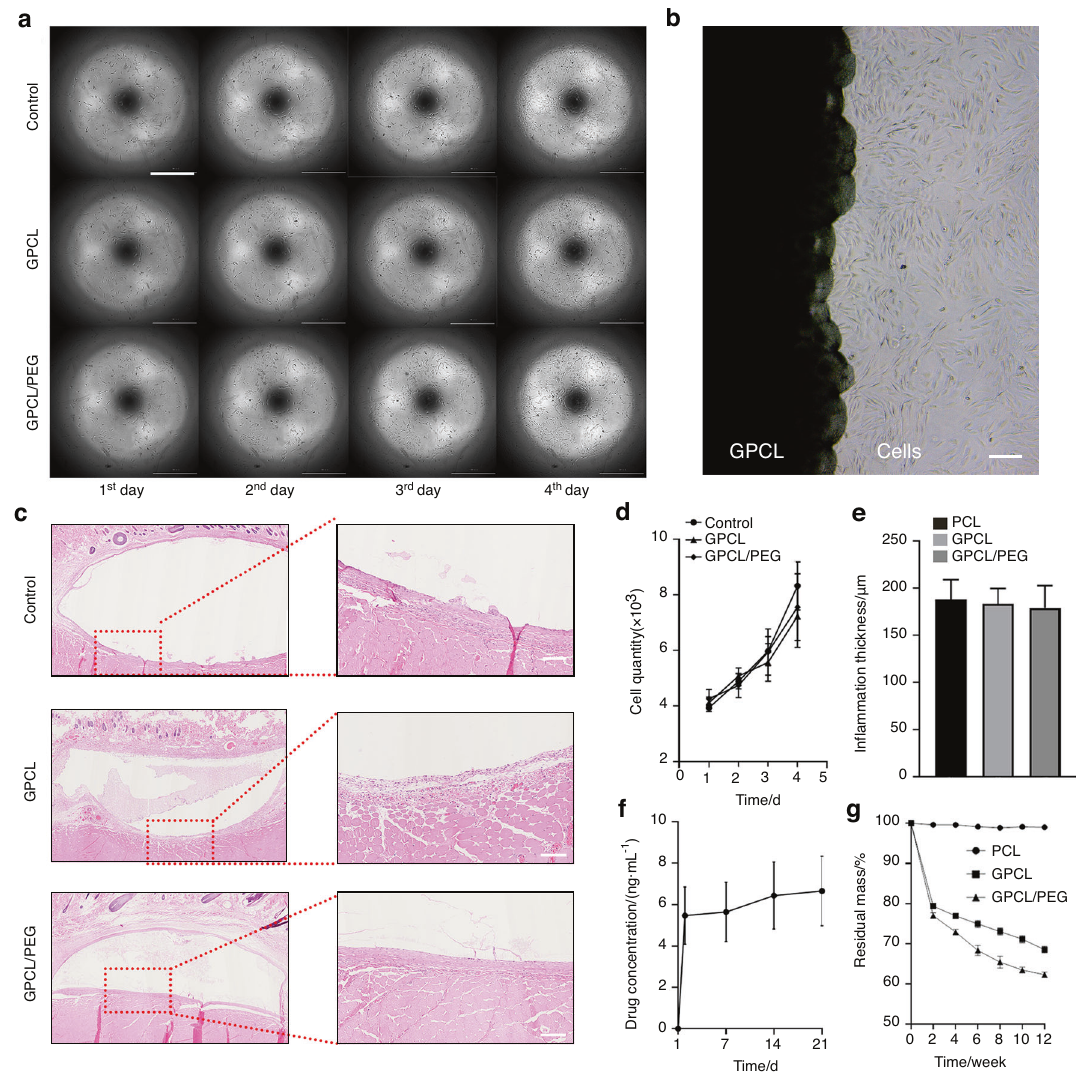
Fig. 2 Biocompatibility and drug release from GPCL. a The proliferation of MC3T3-E1 cells in material extracts. Scale bar: 1 mm. b MC3T3-E1 cells were cultured with GPCL. Scale bar: 100 μ m. c Subcutaneous implantation of materials. Scale bar: 100 μ m. d Quanti fi cation of cell numbers in the cell proliferation assays. e Quanti fi cation of the area of in fl ammation, as determined by implantation assays. f Rate of release of vancomycin loaded into GPCL. g The degradation rate of GPCL in vivo. All values represent the mean ± SEM ( n ≥